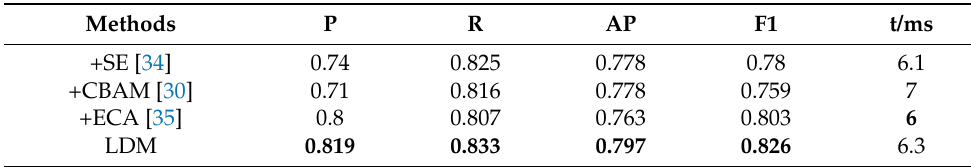
Table 5. The ICB module vs. attention